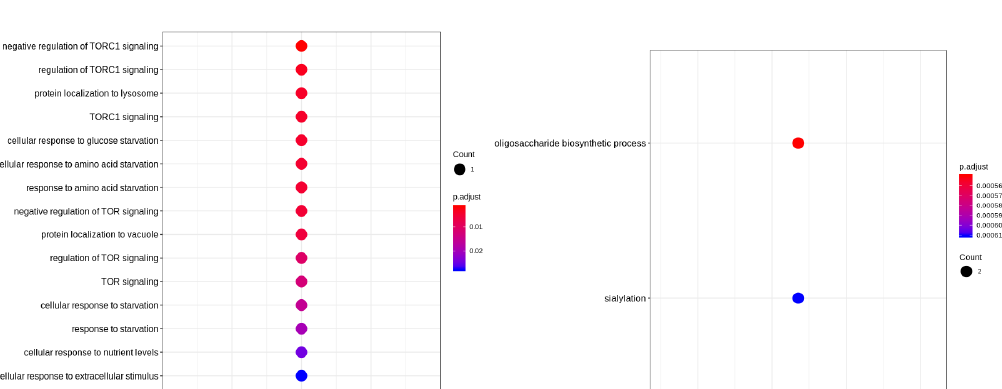
Figure 7. Functional analysis of genes in the different clusters of